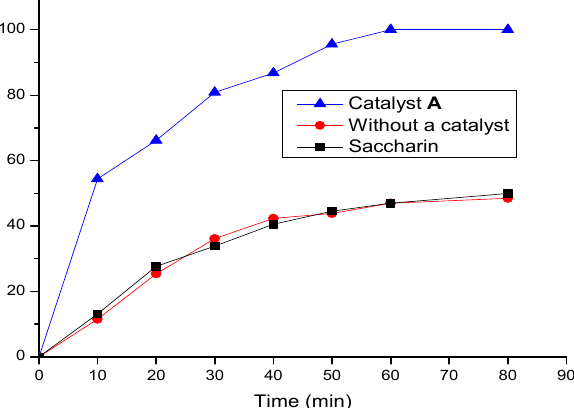
Figure 1. Kinetic study of phospha-Michael addition of diisopropyl phosphite ( 1a ) with benzylidenemalononitrile ( 3 ) with and without a catalyst A . (Note: saccharin as a catalyst was also tested, but it showed no catalytic effect.)